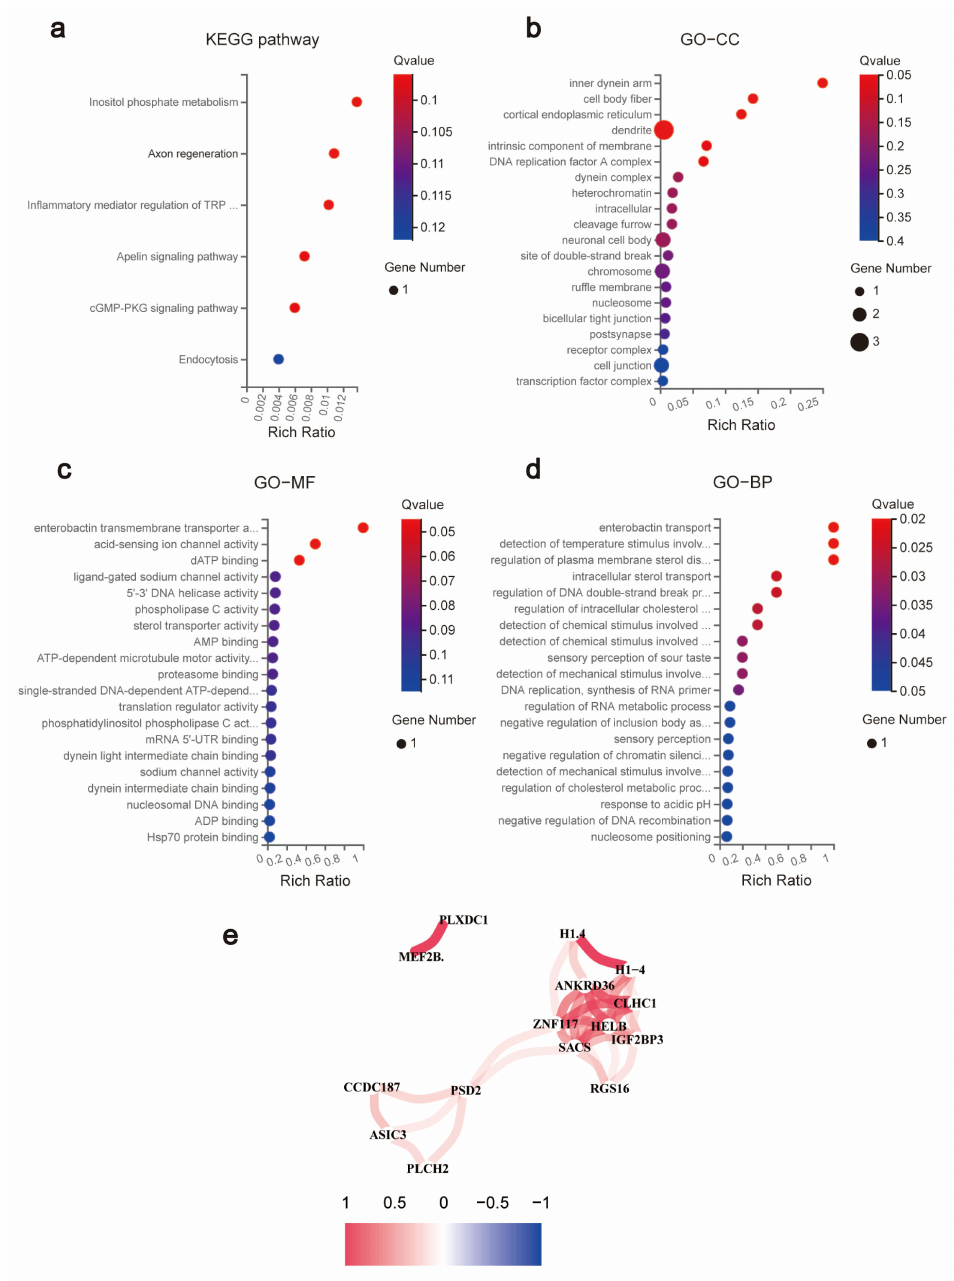
Figure 6. Functional enrichment and correlation analysis of 16 prognosis-related DEGs. ( a ) KEGG pathway analysis. ( b ) GO-CC analysis. ( c ) GO-MF analysis. ( d ) GO-BP analysis. ( e ) Correlation